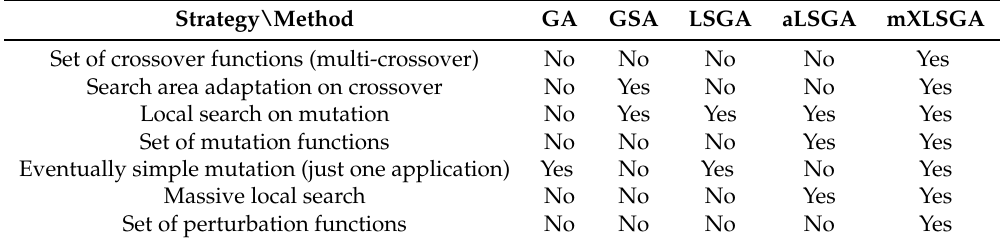
Table 1. Comparison between the use of different strategies by each method. “Yes” means that the method uses the corresponding strategy and “No” means that it does not. Strategy\Method GA GSA LSGA aLSGA mXLSGA Set of crossover functions (multi-crossover) No No No No Yes Search area adaptation on crossover No Yes No No Yes Local search on mutation No Yes Yes Yes Yes Set of mutation functions No No No Yes Yes Eventually simple mutation (just one application) Yes No Massive local search